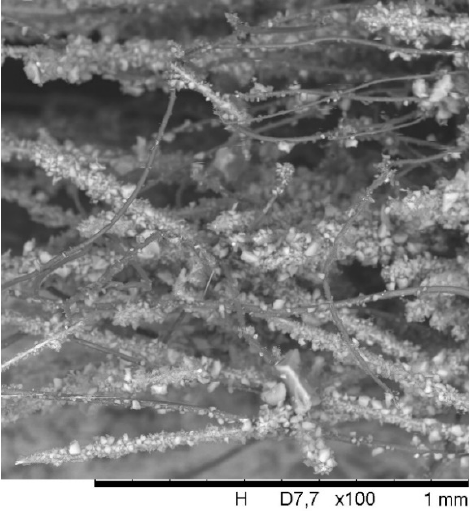
Figure 2. SEM image of the as-received sample.